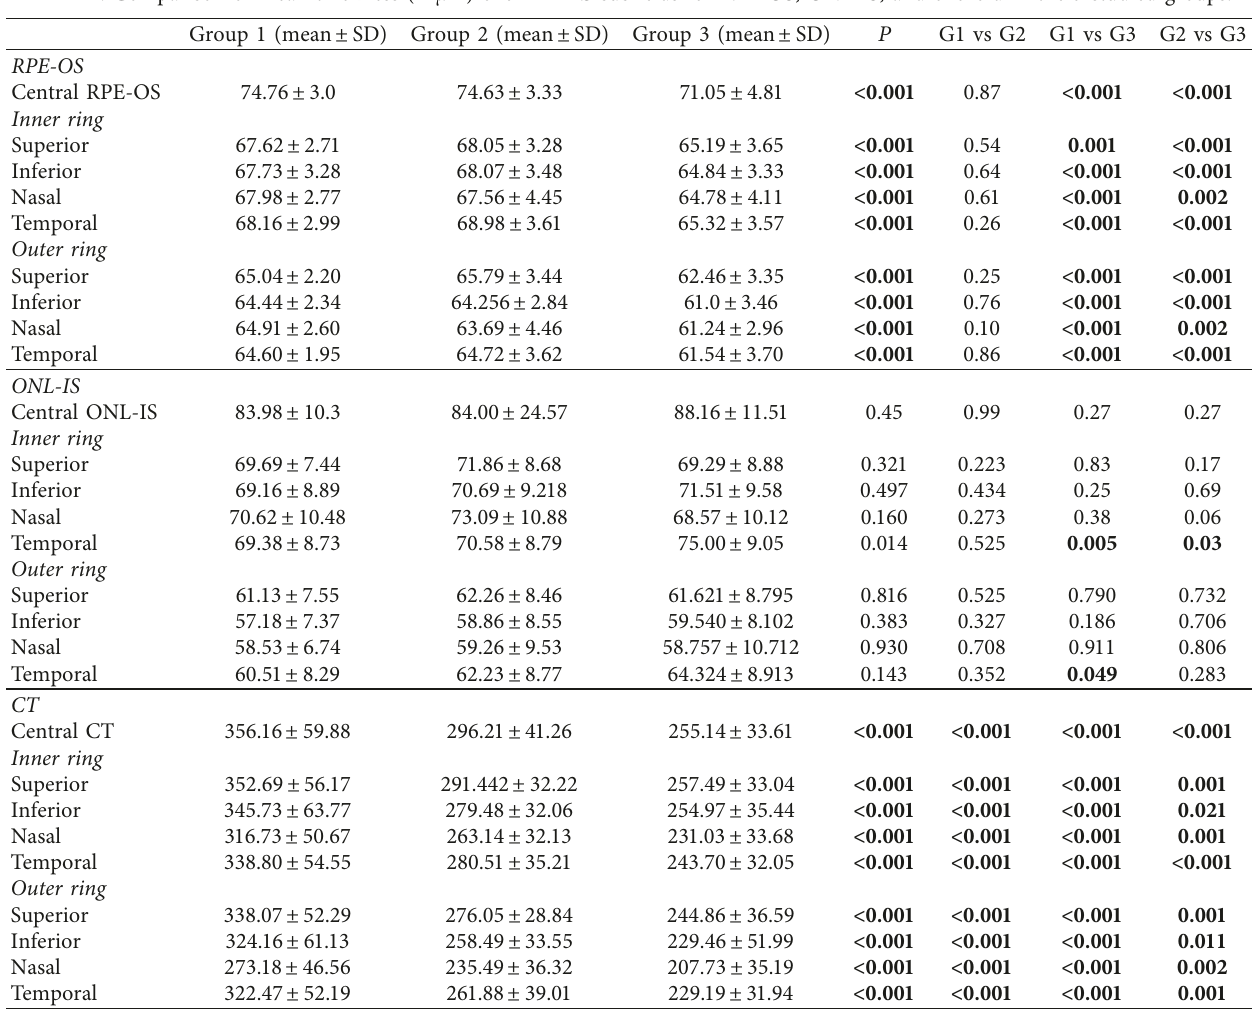
Table 2: Comparison of mean thickness (in μ m) of 9 ETDRS subfields for RPE-OS, ONL-IS, and choroid in the 3 studied